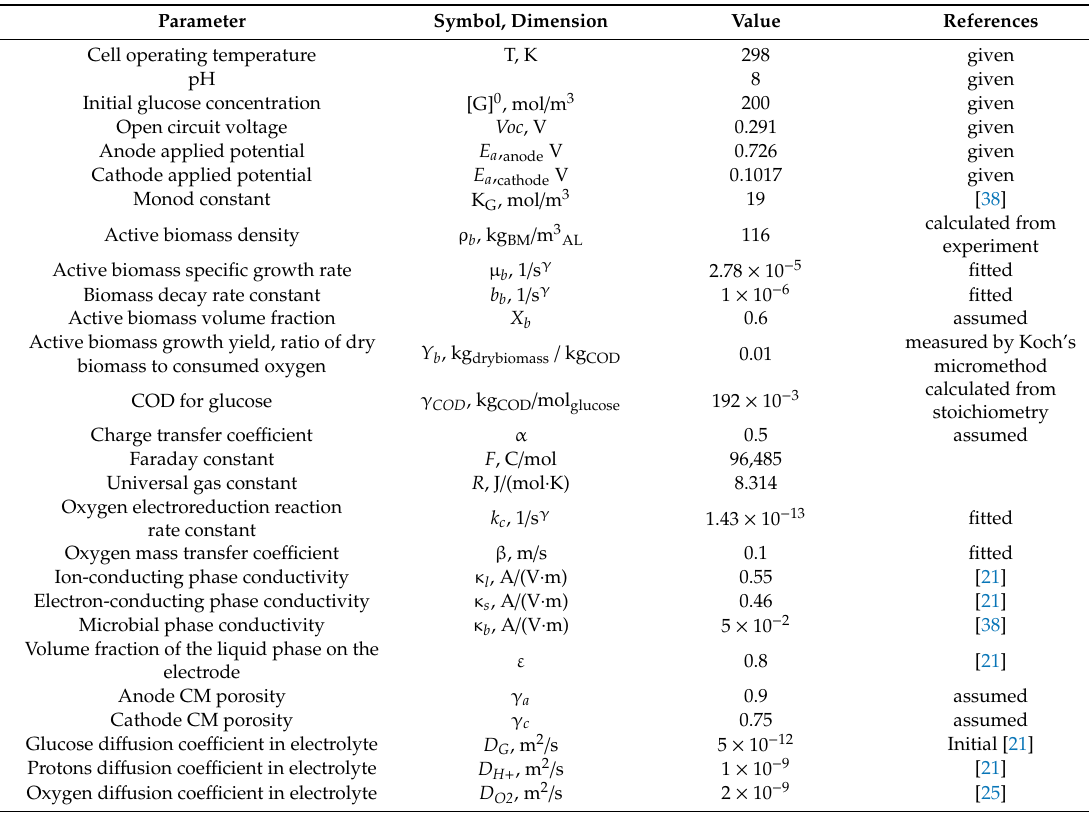
Table 2. List of simulation parameters.